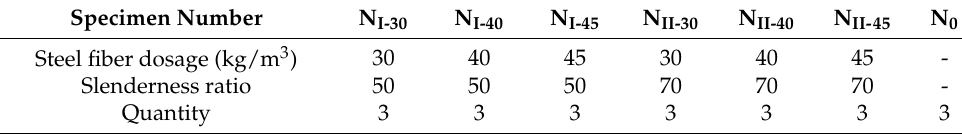
Table 4. Grouping and numbering of specimens under the fire